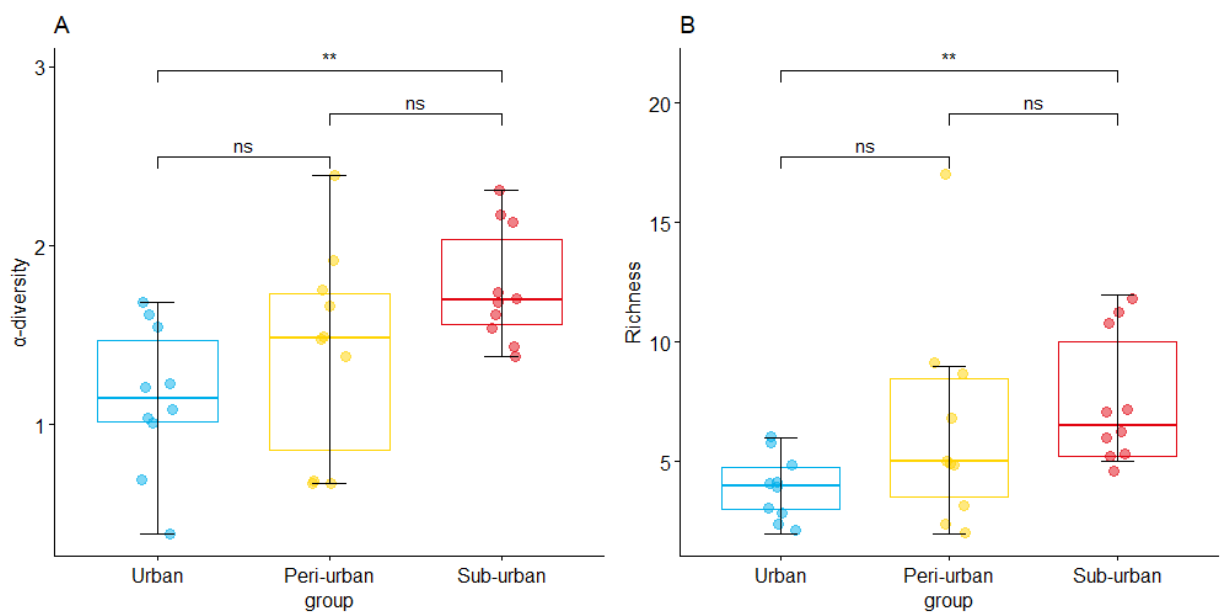
Figure 4. Insectivorous guild α -diversity ( A ) and richness ( B ) under different urbanization types of mountain parks. Boxplots show the range of data about the median, with open circles representing outliers and filled circles representing the mean. Stars indicate significance levels (ns = not significant; ** = p < 0.01).